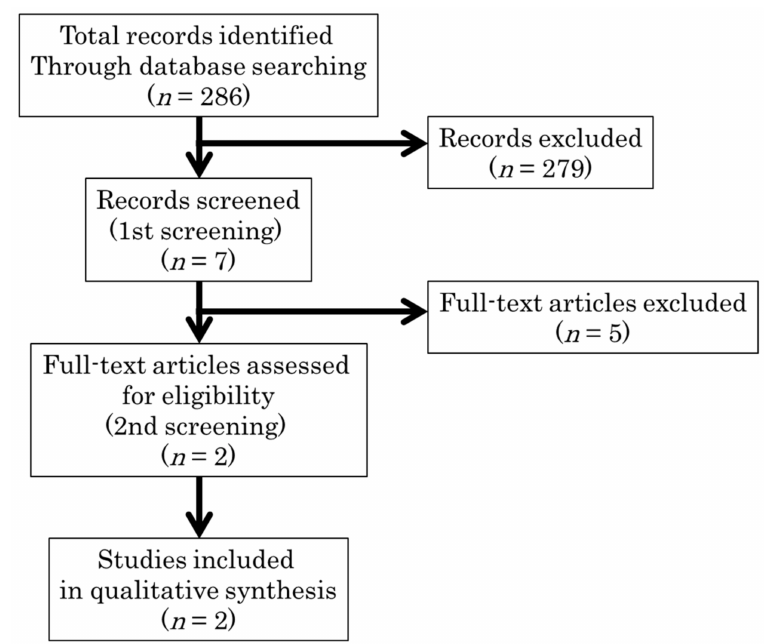
Figure 1. Flow diagram of selecting the energy restriction studies included in our study. Two randomized controlled trials were appraised in our systematic review.